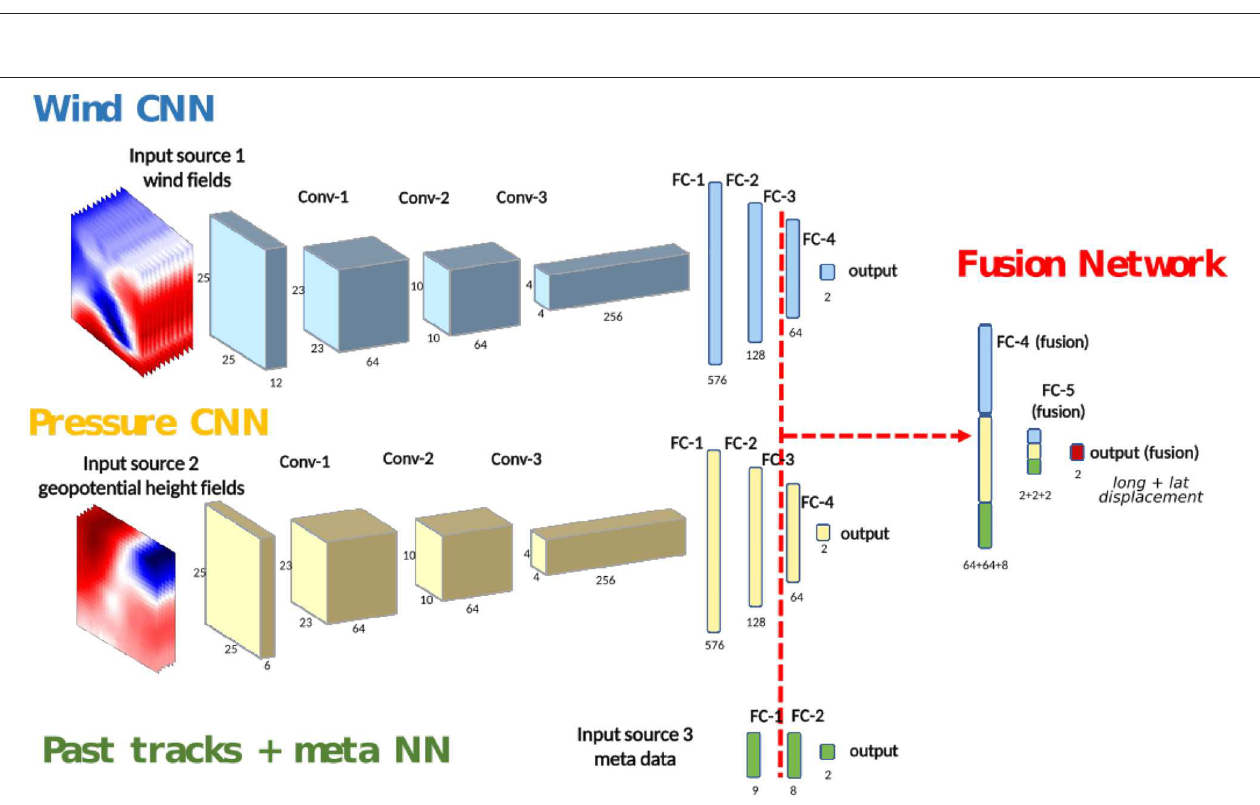
FIGURE 2 | General architecture: the three types of data feed three neural networks trained separately. The final fused network is re-trained before predicting the 24 h-forecast displacement.